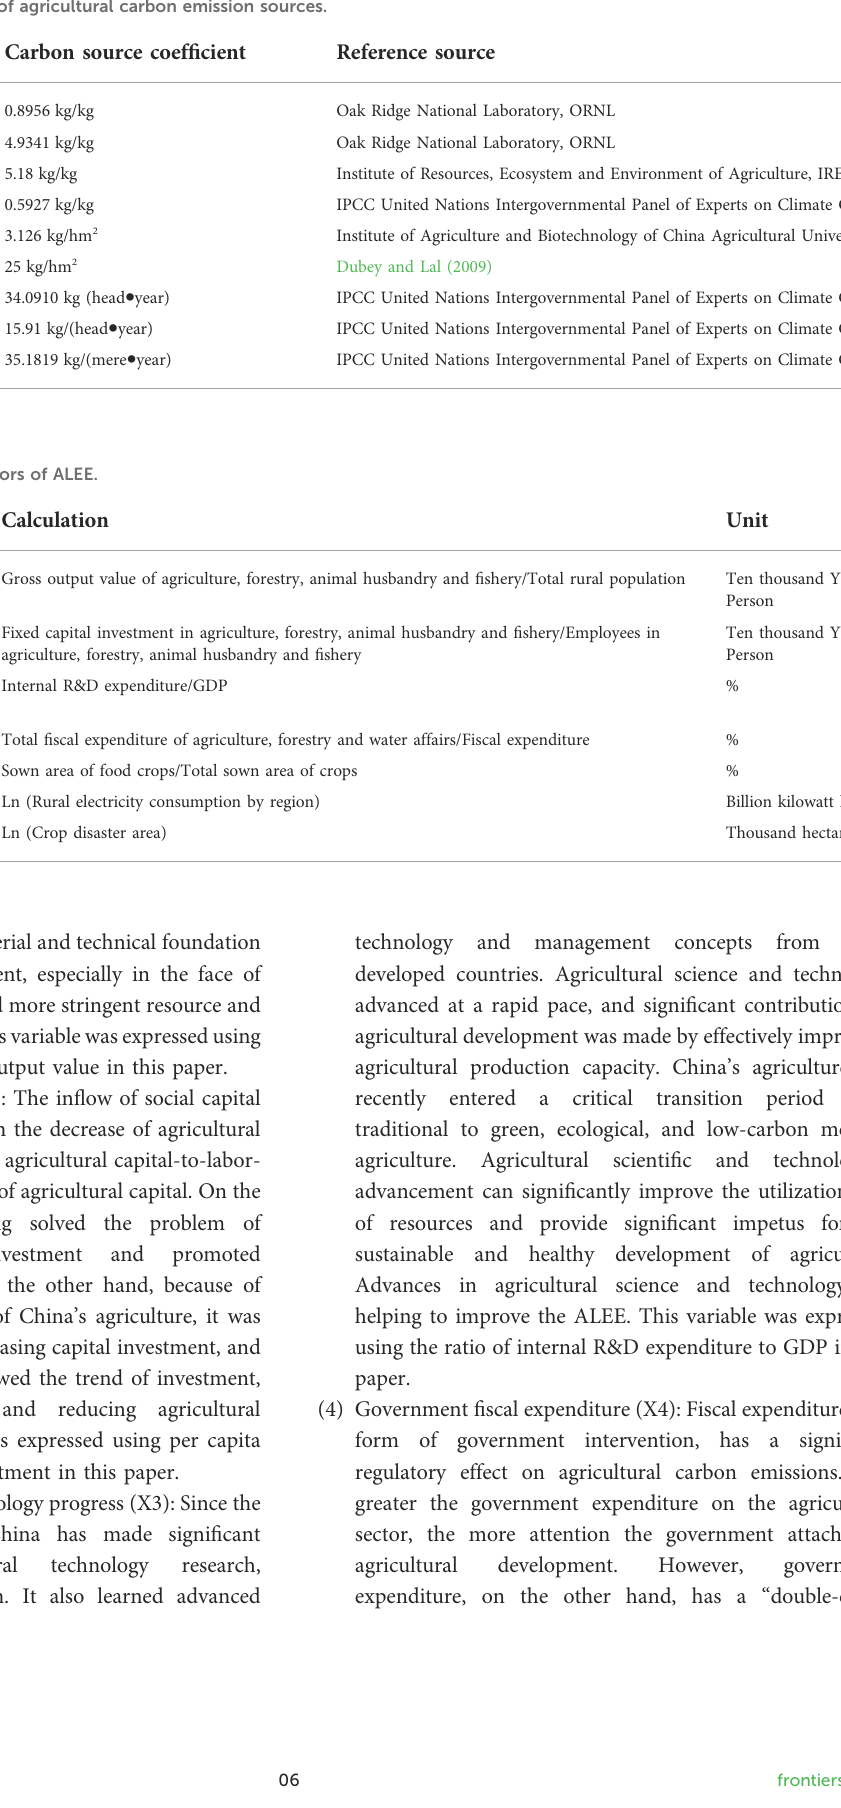
TABLE 2 Carbon emission coef fi cient of agricultural carbon emission sources.